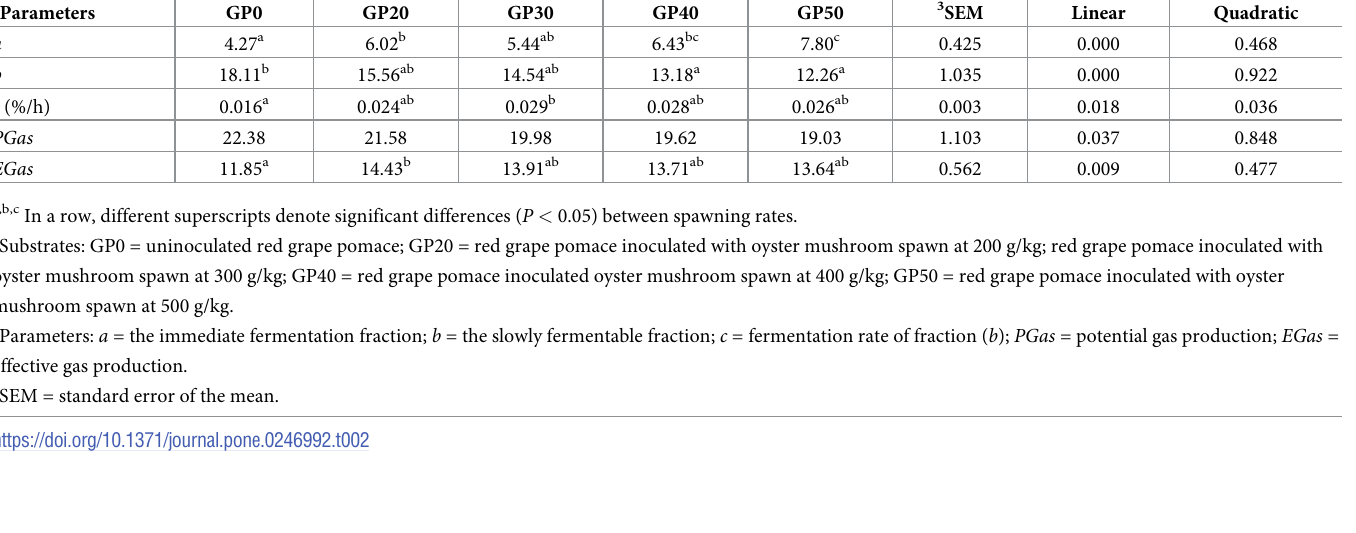
Table 2. In vitro ruminal gas production parameters of red grape pomace spent oyster mushroom substrate. 1 Substrates Significance 2